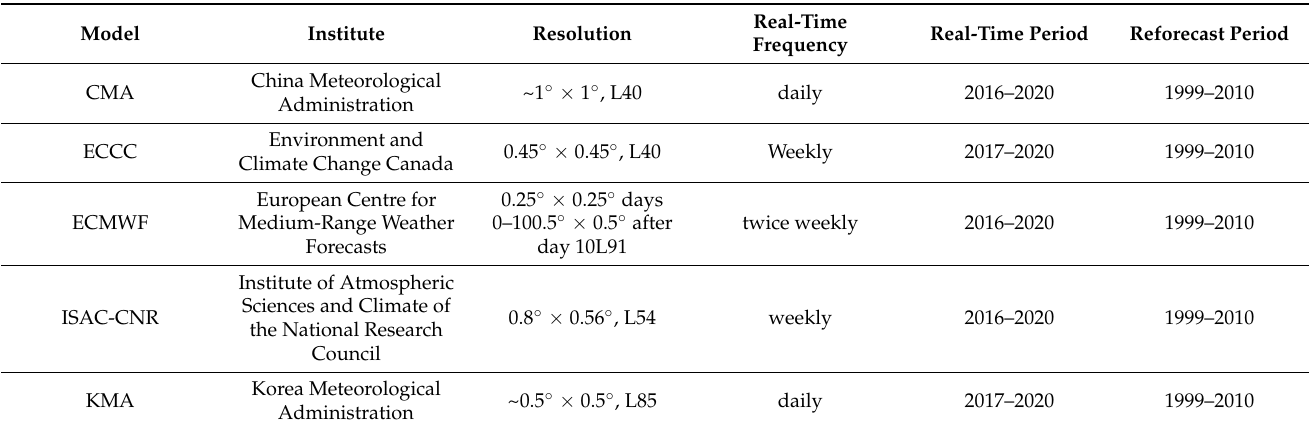
Table 1. Brief descriptions of the selected S2S